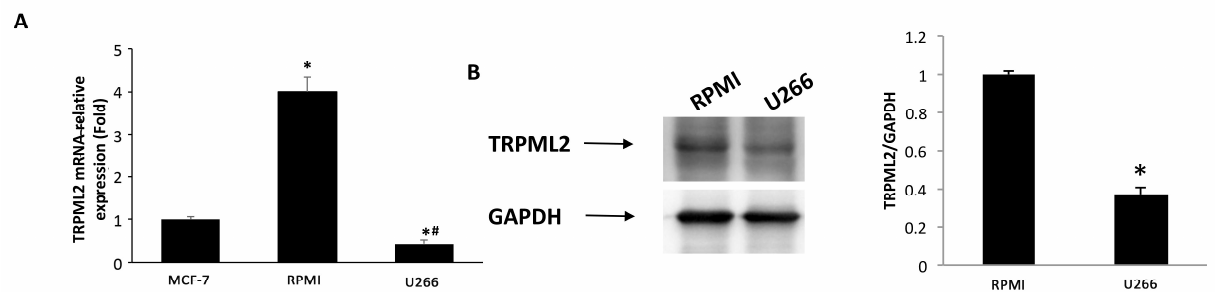
Figure 7. TRPML2 expression in MM cell lines. ( A ) The relative TRPML2 mRNA expression in RPMI and U266 cells was evaluated by qRT-PCR. MCF-7 breast cancer cell line has been used as positive control [32]. TRPML2 mRNA levels were normalized for glyceraldehyde-3-phosphate dehydrogenase (GAPDH) expression. Data are expressed as the mean ± SD. * p < 0.01 vs. MCF-7, # p < 0,01 vs. RPMI. ( B ) Total lysates were separated on 8% SDS-PAGE and probed with anti-TRPML2 Ab. Blots are representative of one of three separate experiments. Densitometry values were normalized to GAPDH, which was used as loading control. Data are expressed as the mean ± SE of three separate experiments. * p < 0.05.